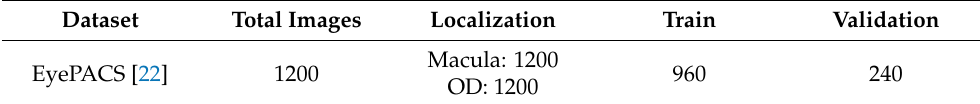
Table 8. Human opinion labeling description and hold-out strategy for training